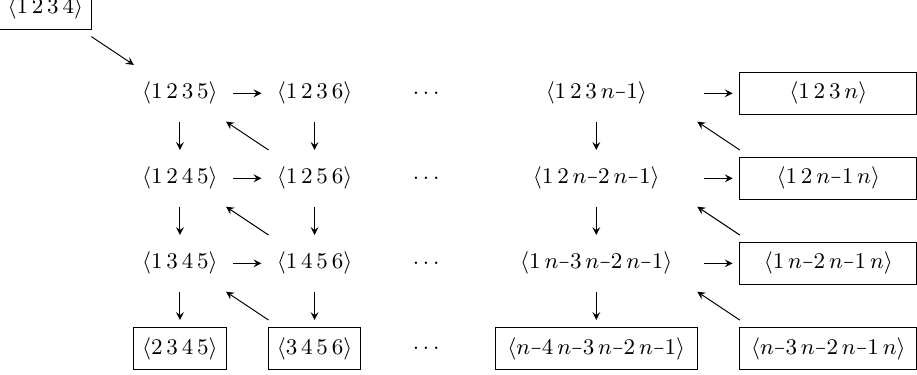
Figure 1. The initial cluster of the Grassmannian series Gr(4 ; n